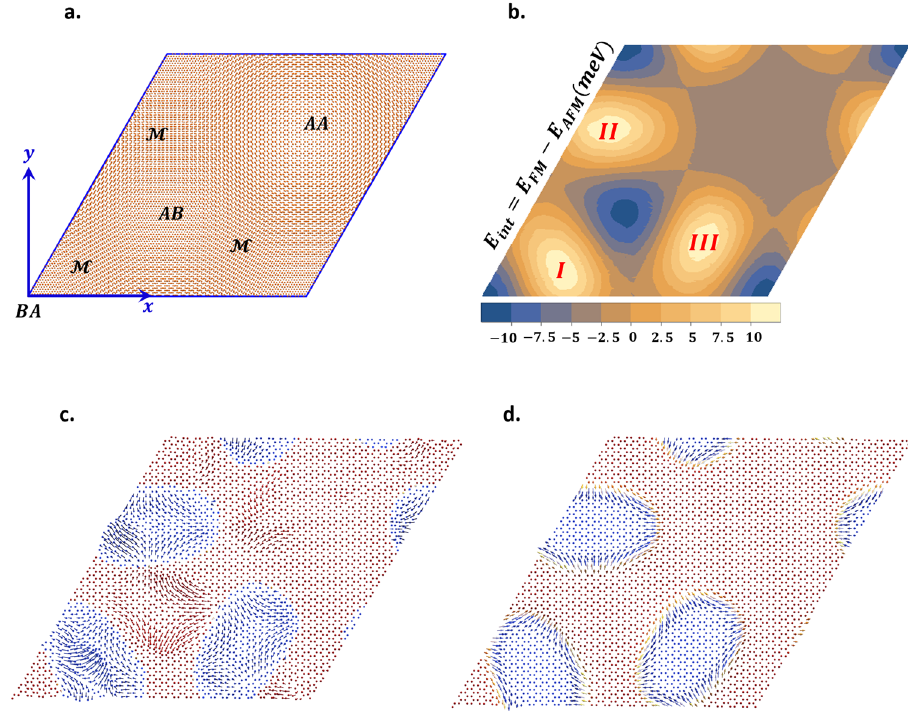
Fig. 1 Antivortex moiré interlayer fi eld stabilizing ground state antiskyrmions in the nonchiral Heisenberg model. a Rhombohedral (BA, AB, and AA) and monoclinic ( M ) stacking regions in the CrI 3 moiré supercell for a twist angle θ ¼ 0 : 96 (cid:2) . b The interlayer exchange energy ( E int ) as a function of the interlayer translation in a moiré supercell. The plot is reproduced from the density functional theory data shared by the authors of a previous work 53 . The interlayer coupling is antiferromagnetic in the monoclinic regions (I, II, and III). c , d The normalized moiré interlayer fi eld ( c ) and antiskyrmions at 0 K ( d ), obtained in the Heisenberg model for twist angle θ ¼ 1 : 35 (cid:2) and external magnetic fi eld strength B ¼ 1 T . The interlayer fi eld displays antivortex textures at the antiferromagnetic regions and stabilizes the antiskyrmions. The vectors are presented using a temperature-color map which indicates the out-of-plane components ranging from − 1 (blue) to 1 (red). Table 1 Models ’